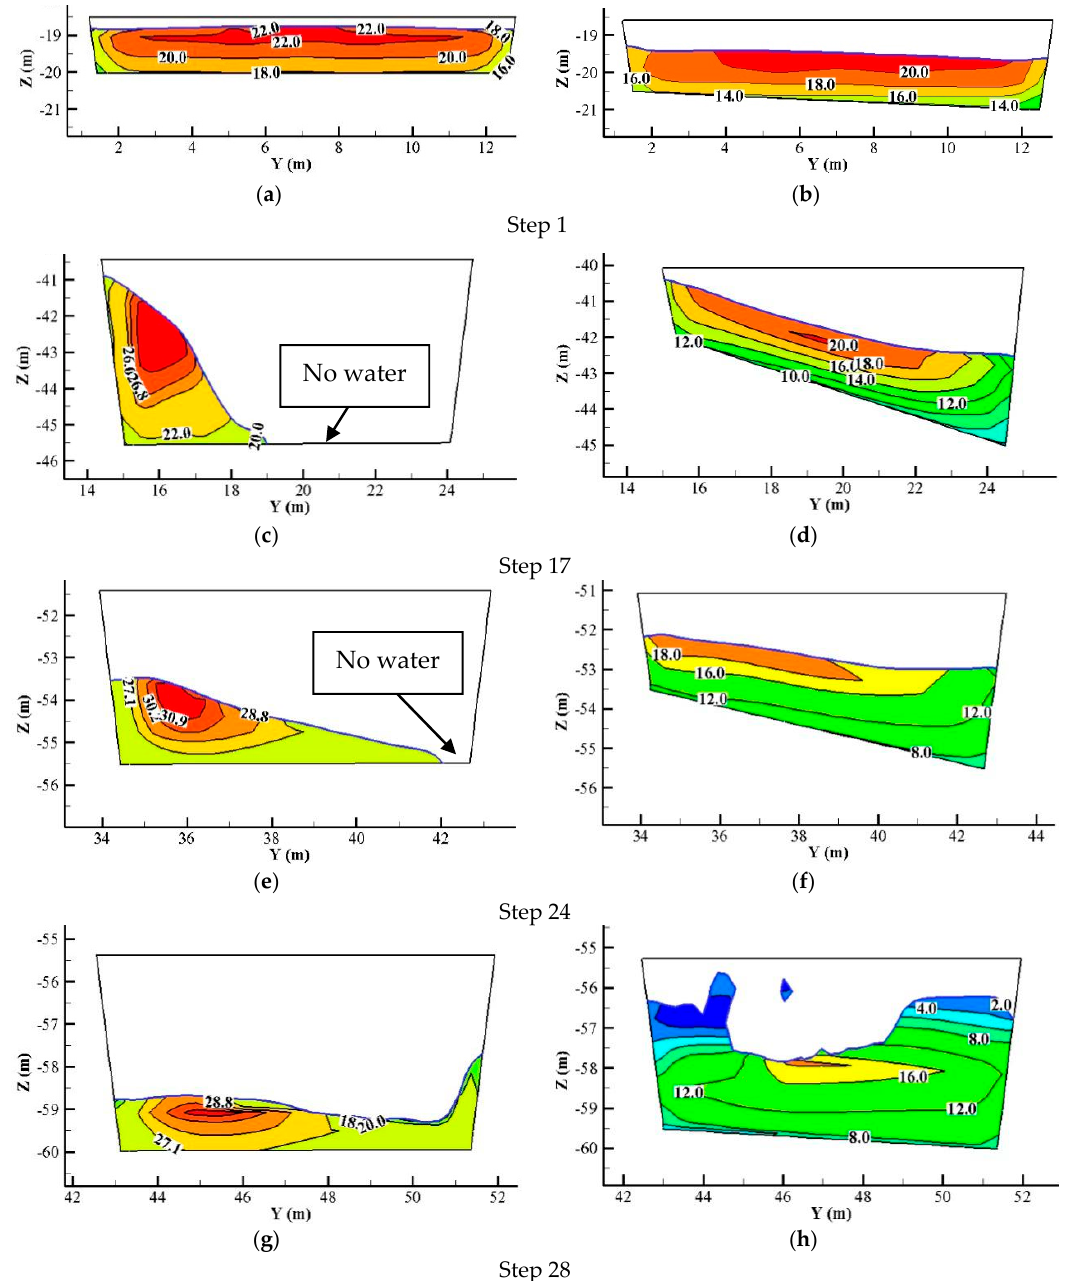
Figure 14. The cross-sectional velocity distributions at the ends of steps No. 1, 17, 24, and 28 of the smooth spillway and step spillway. ( a , c , e , g ) are smooth spillways; and ( b , d , f , h ) are stepped spillways.